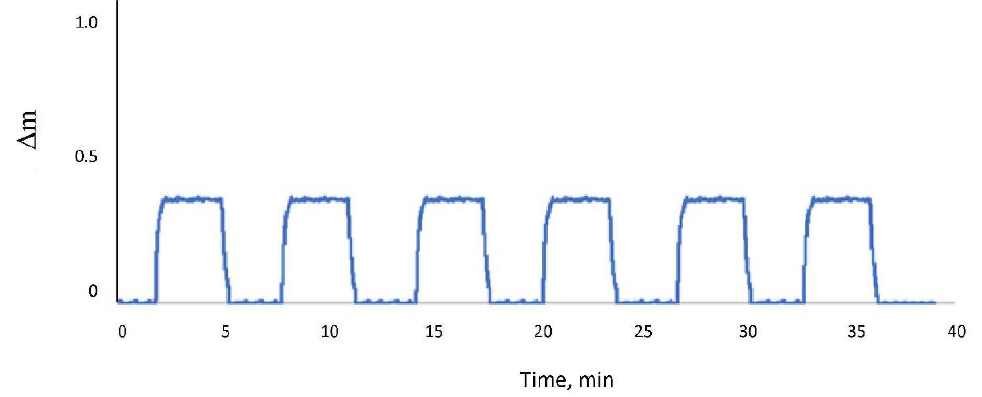
Figure 6. Based on mass changes ( ∆ m), performance of HER2/neu functionalized QCM sensor in repeated cycles. Table 3. ∆ m , k and k’ values for HER2/neu based PHEMA NPs coated and only PHEMA NPs coated QCM chips after selectivity studies with SKBR3, MDA-MB-231 and L929 cell lines.